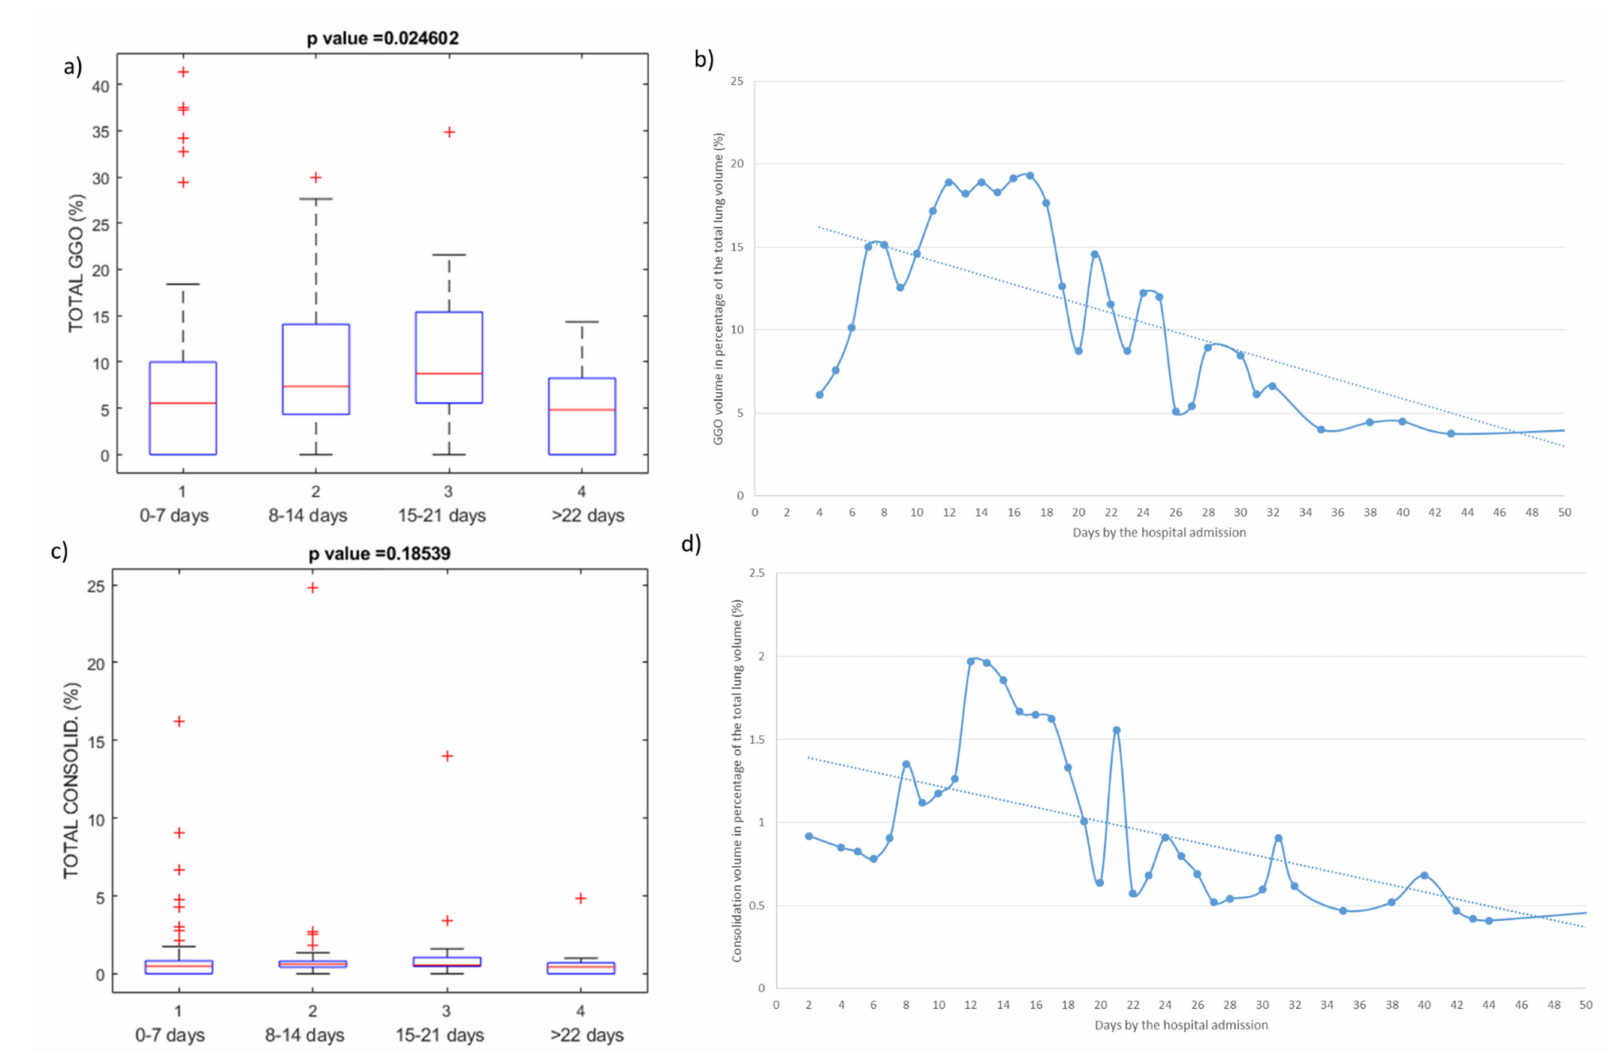
Figure 3. Temporal course of quantified volume on chest CT: in ( a ) and ( c ) boxplots of GGO volume and consolidation volume grouping the temporal course in 0–7 days (N. 25), 8–14 days (N. 50), 15–21 days (N. 37), and >22 days (N. 28); in ( b ) and ( d ) the temporal course of GGO and consolidation volume as a percentage value of total lung